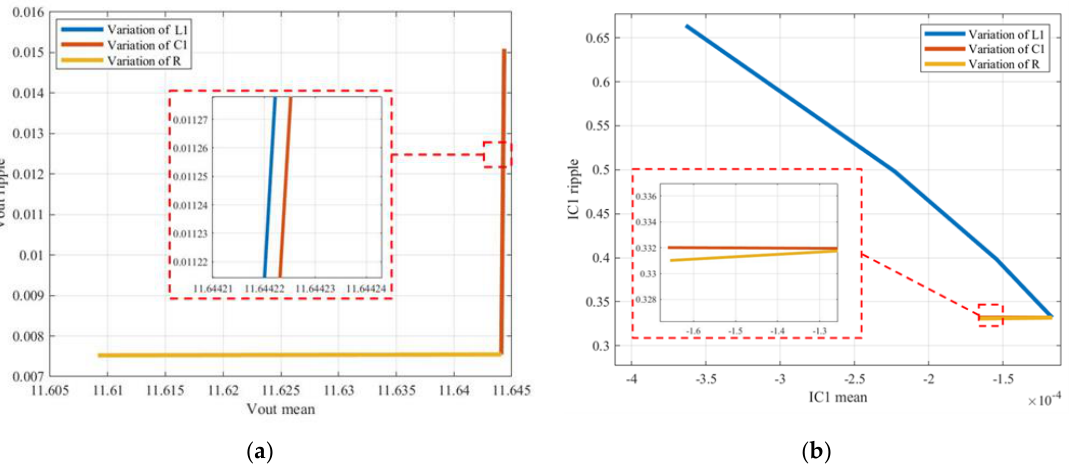
Figure 7. Testability curves during the switch-on period: ( a ) variations introduced in the output voltage; ( b ) variations introduced in the capacitor current.